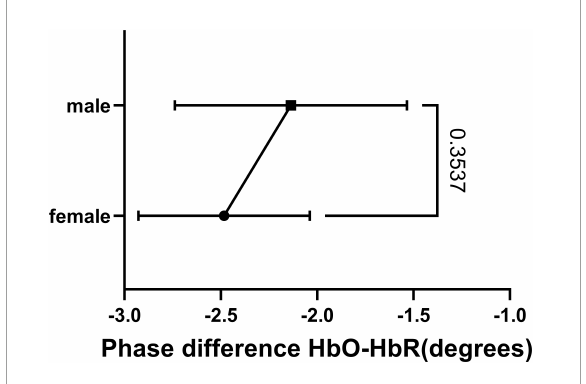
FIGURE8 Result of t -test of HbO-HbR phase difference between female and